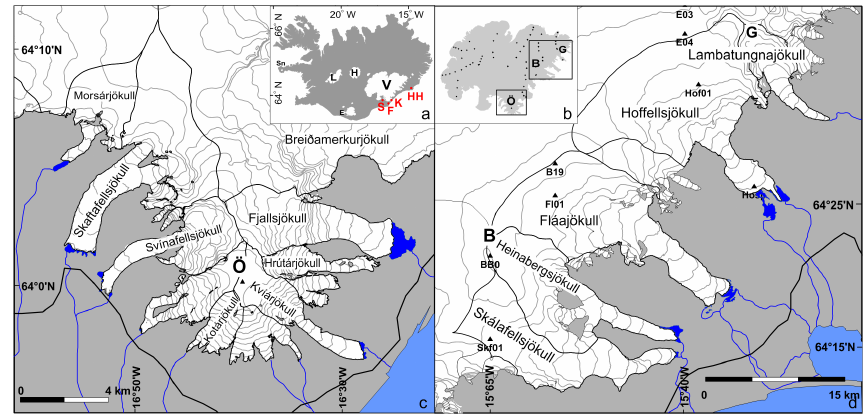
Figure 1. (a) Iceland and Vatnajökull (V) and other ice caps and glaciers mentioned in the text, Hofsjökull (H), Langjökull (L), Eyjafjallajökull (E), and Snæfellsjökull (Sn). Weather stations in Skaftafell (S), Fagurhólsmýri (F), Kvísker (K) and Hólar in Hornafjörður (HH). (b) Vatnajökull and mass balance stakes (black dots). The rectangles show the outline of figures (c) the outlet glaciers descending from Öræfajökull ice cap (Ö) and Morsárjökull, and (d) the outlet glaciers east of Breiðamerkurjökull, descending from the Breiðabunga dome (B), and Goðahnúkar (G). The surface topography is from the 2010 lidar DEMs, with 100m contour lines, and ice divides are delineated in black. The location of mass balance measurements is indicated with triangles. Note the different scale of the two figures. Proglacial lakes and rivers are shown in blue and highway 1 in